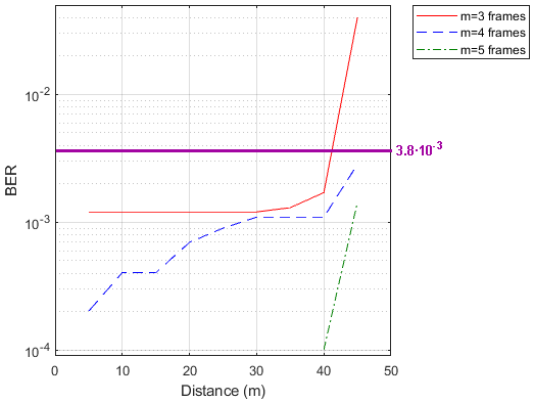
Figure 15. Communication BER for α =